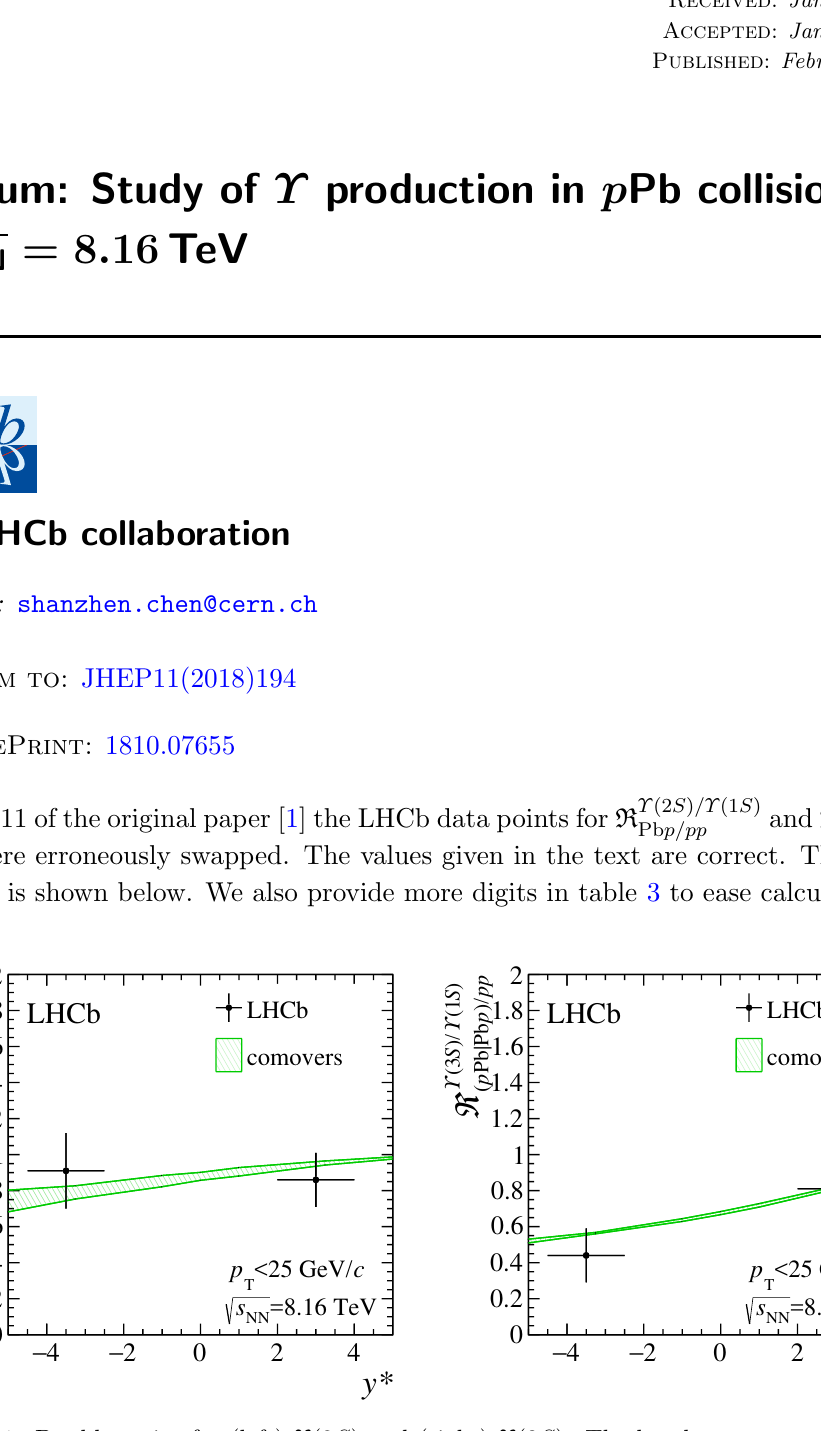
Figure 11 . Double ratios for (left) (cid:7) (2 S ) and (right) (cid:7) (3 S ). The bands correspond to the theo- retical prediction for the comovers model as reported in the